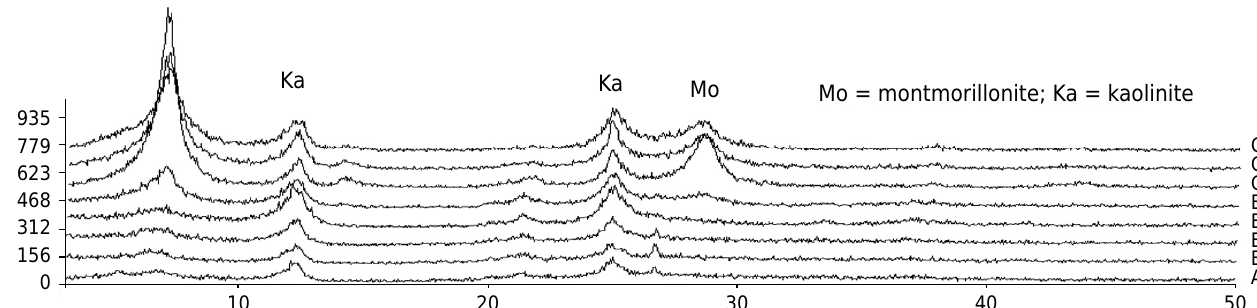
Figure 2. X ray diffractogram of clay fractions from soil profile